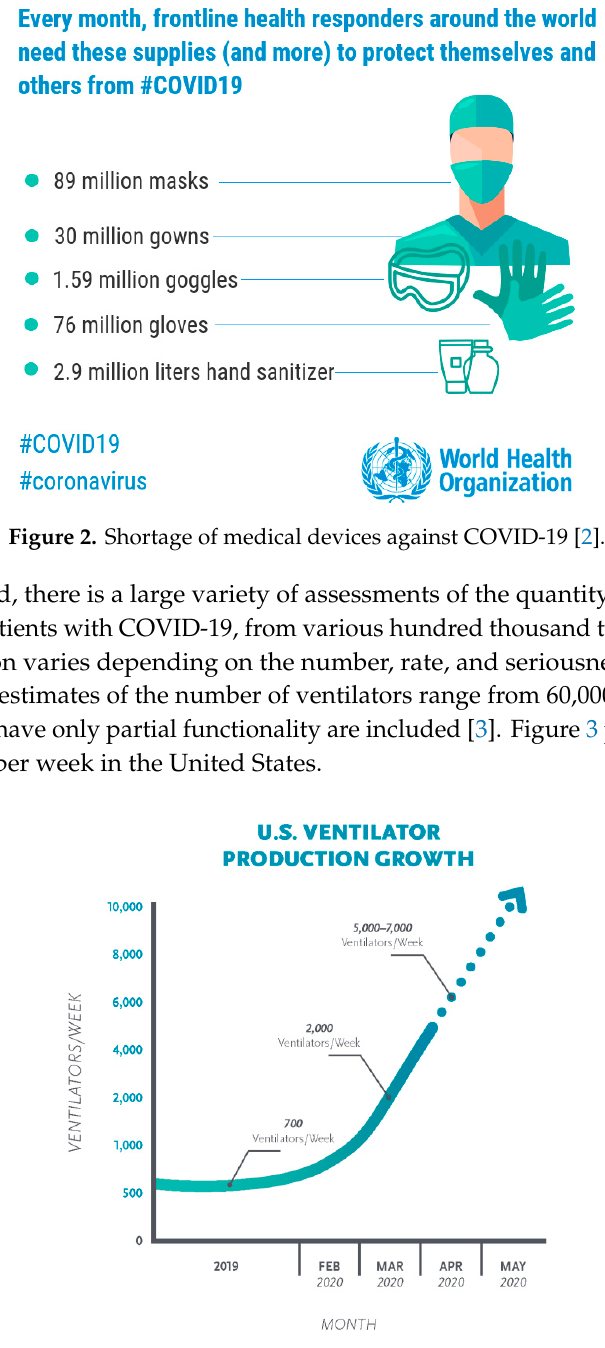
Figure 3. Production growth of ventilators in the USA [4].